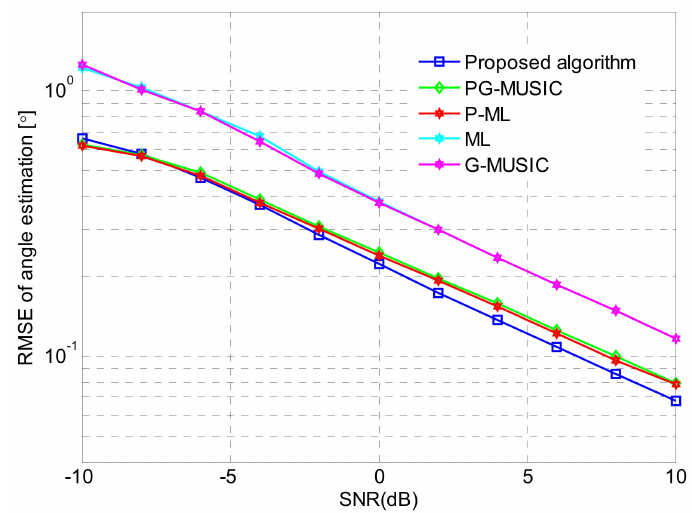
Figure 3. RMSE of angle estimation versus